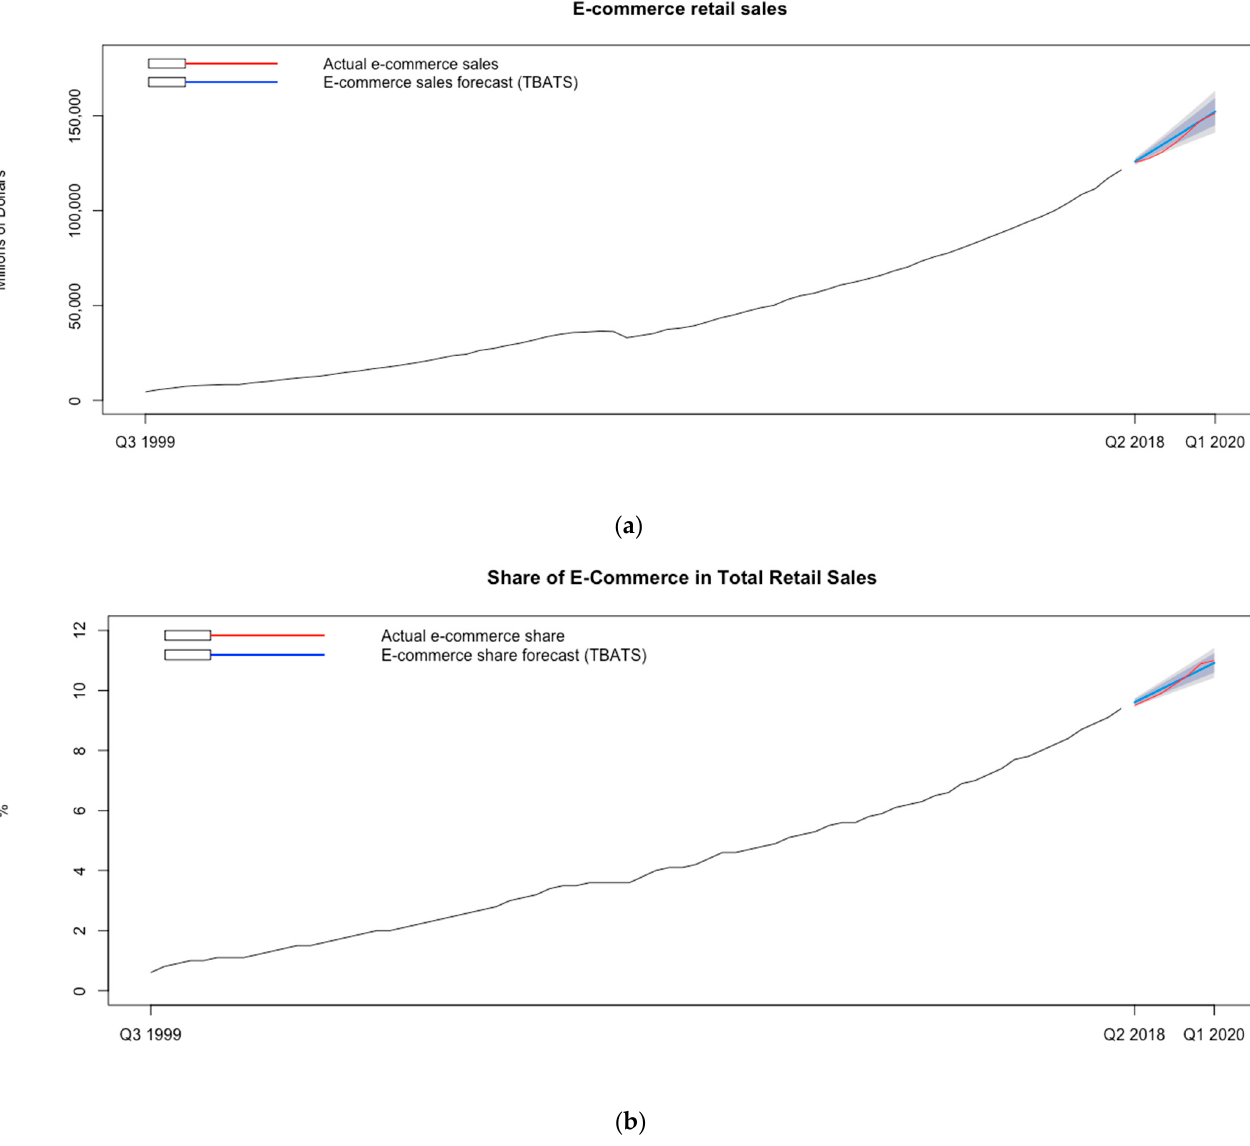
Figure A1. ( a ) Forecasted trend for e-commerce retail sales over April 2018-January 2020 issued with TBATS. Source: estimation results. ( b ) Forecasted trend for e-commerce share in total retail sales over April 2018-January 2020 issued with TBATS. Source: estimation results.